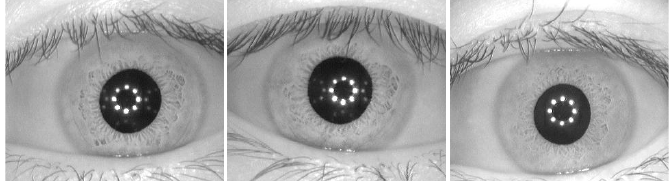
Figure 3. Sample images from the (Chinese Academy of Sciences’ Institute of Automation) CASIA-Iris-Interval dataset.